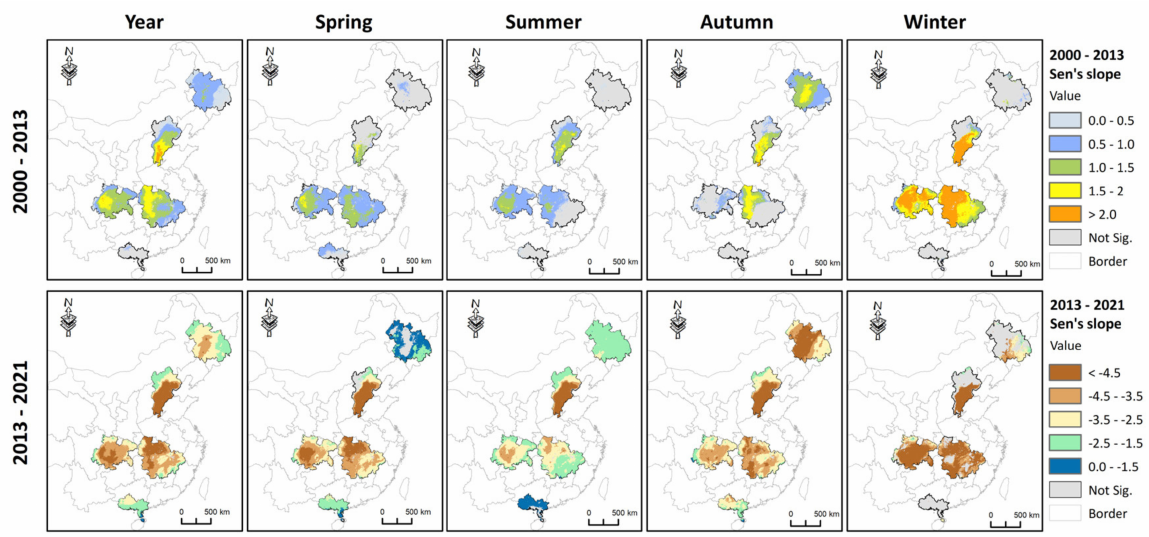
Figure 5. Trend changes of PM 2.5 concentrations in the five UAs during 2000–2013 and 2013–2021. “Not Sig.” means the confidence level was greater than 0.05. A Sen’s slope value greater than 0 indicates an increasing trend in PM 2.5 concentrations, while a value less than 0 indicates a decreasing trend in PM 2.5 concentrations. The unit of the Sen’s slope is µ g/m 3 /y. As shown in Figure 6, during 2000–2013, the trend changes of the annual average PM 2.5 concentration in the study area were 0.5–1.0 (33.12%, where % represents the proportion